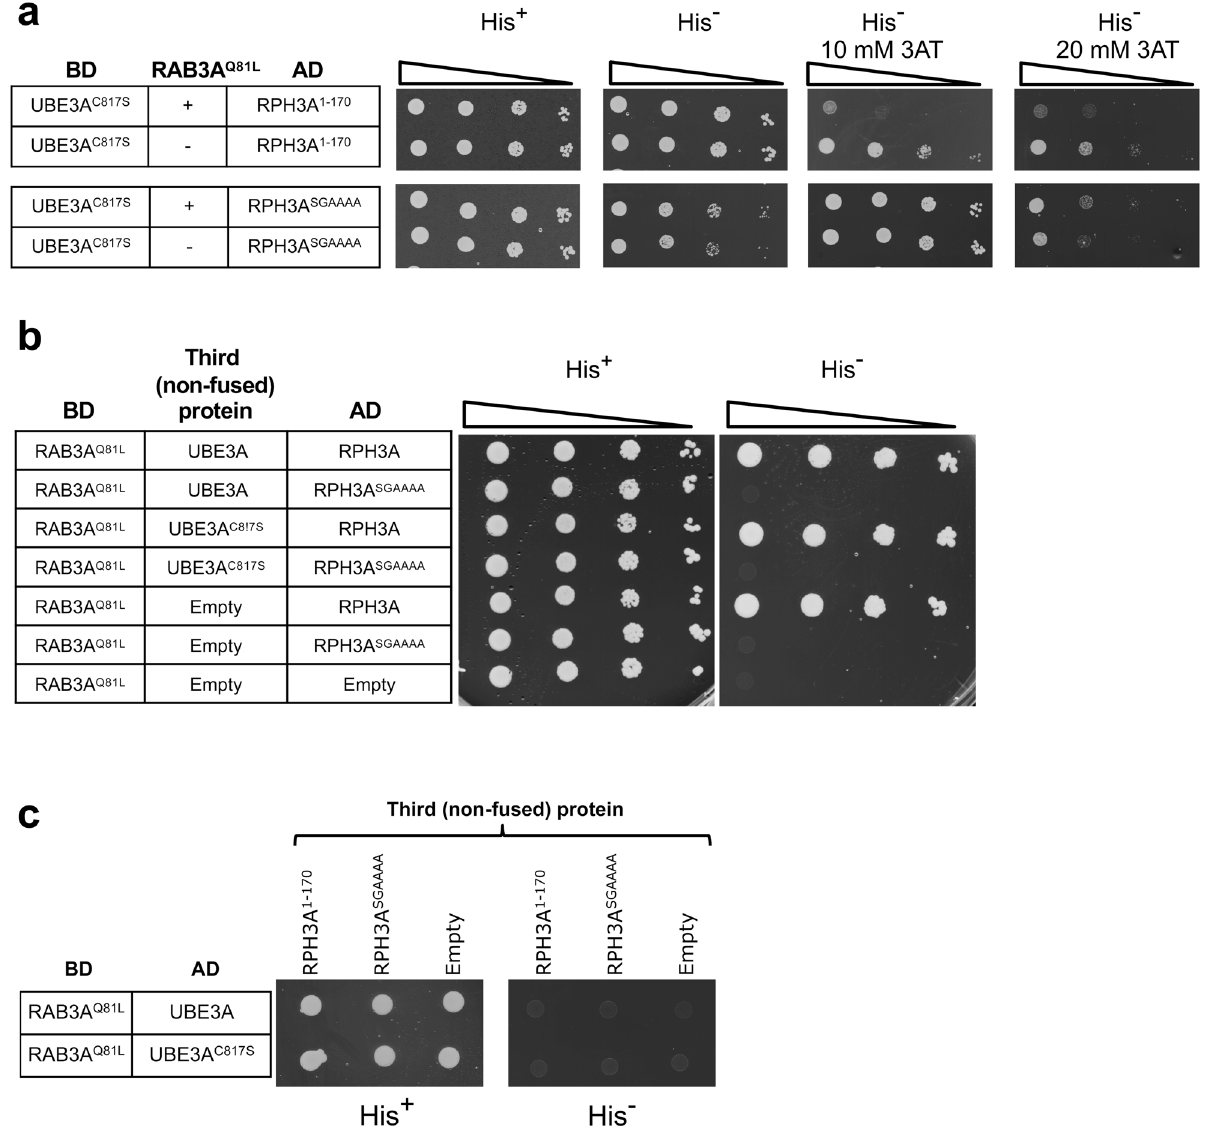
Figure 4. UBE3A and RAB3A cannot simultaneously bind to RPH3A. (a) RAB3A interferes with the UBE3A- RPH3A interaction. S. cerevisiae strain PJ69a was co-transformed with UBE3A C817S (bait), RPH3A 1–170 or RPH3A SGAAAA (preys), and non-fused RAB3A Q81L or empty vector (pRA1). Cells were spotted on selective plates as indicated. (b) UBE3A does not interfere with the RAB3A-RPH3A interaction. S. cerevisiae strain PJ69a was co-transformed with RAB3A Q81L (bait), RPH3A 1–170 , RPH3A SGAAAA or empty vectors (preys) and non-fused UBE3A, UBE3A C817S or empty vector. Cells were spotted on selective plates as indicated. (c) RPH3A cannot bridge the RAB3A-UBE3A interaction. S. cerevisiae strain PJ69a was co-transformed with RAB3A Q81L (bait), UBE3A or UBE3A C817S (preys), and the indicated non-fused RPH3A constructs or empty vector (pRA1). Cells were spotted on selective plates as